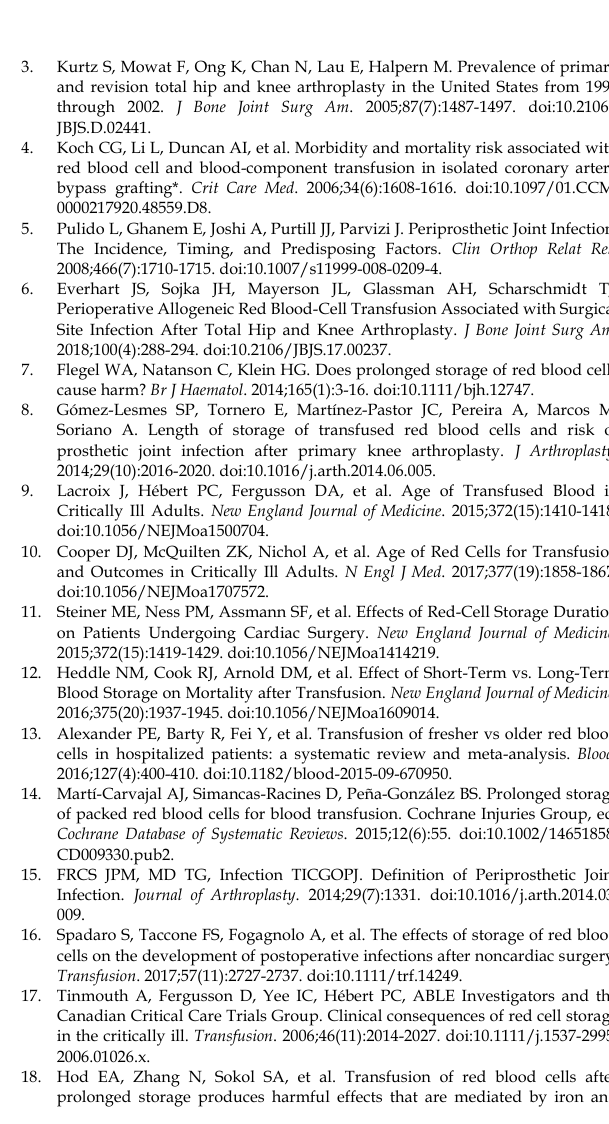
Figure 3. Percentage of early prosthetic joint infection (EPJI) within the first 365 days after joint arthroplasty according to year of surgery and mean time of storage (<14 days or >14 days) of packed red blood cell transfused during surgery or within the first 6 hours after surgery.